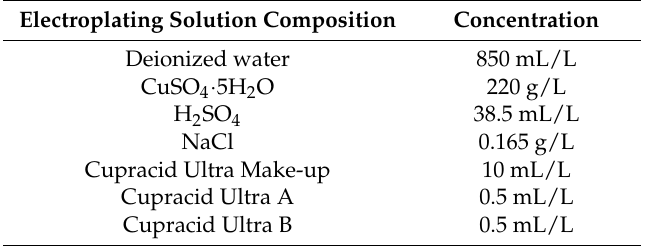
Table 1. The basic electroplating solution composition. (Applied in